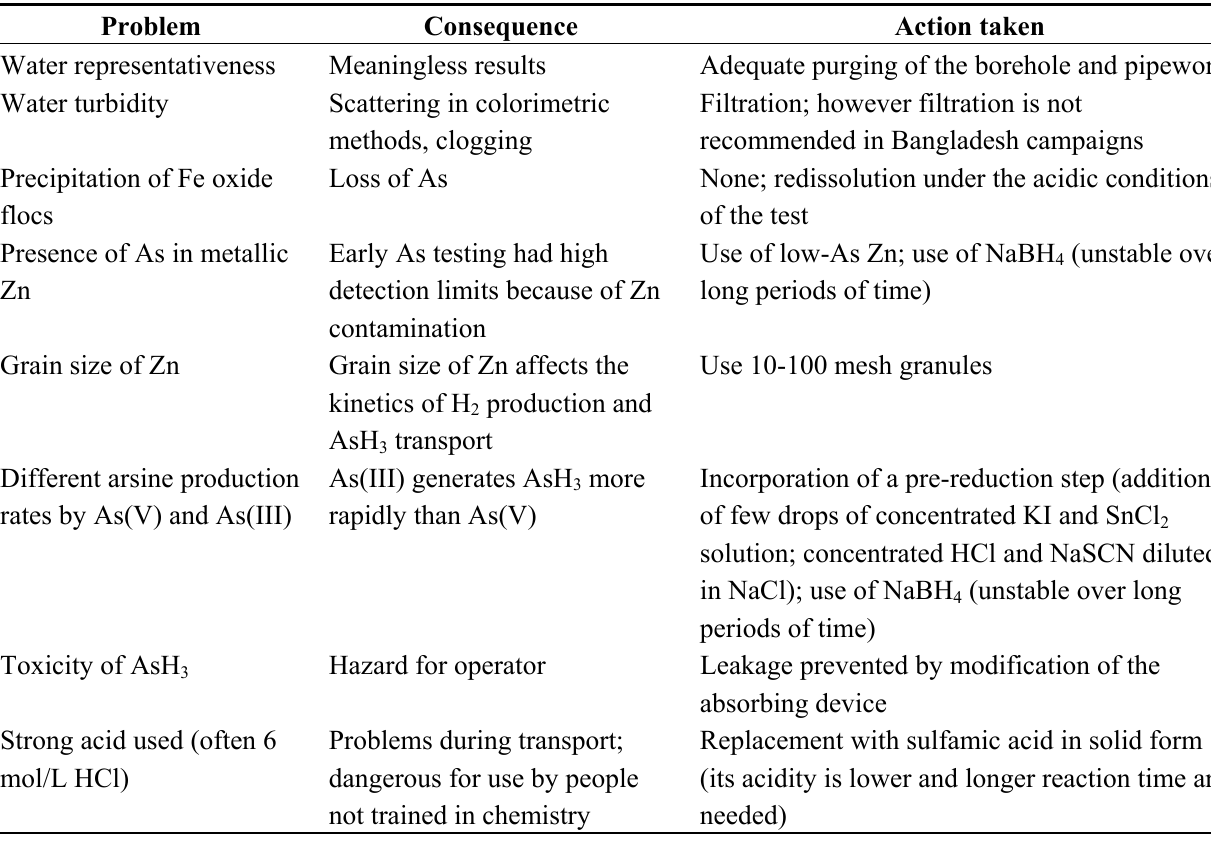
Table 1. Arsenic field kits. Problems involved and actions